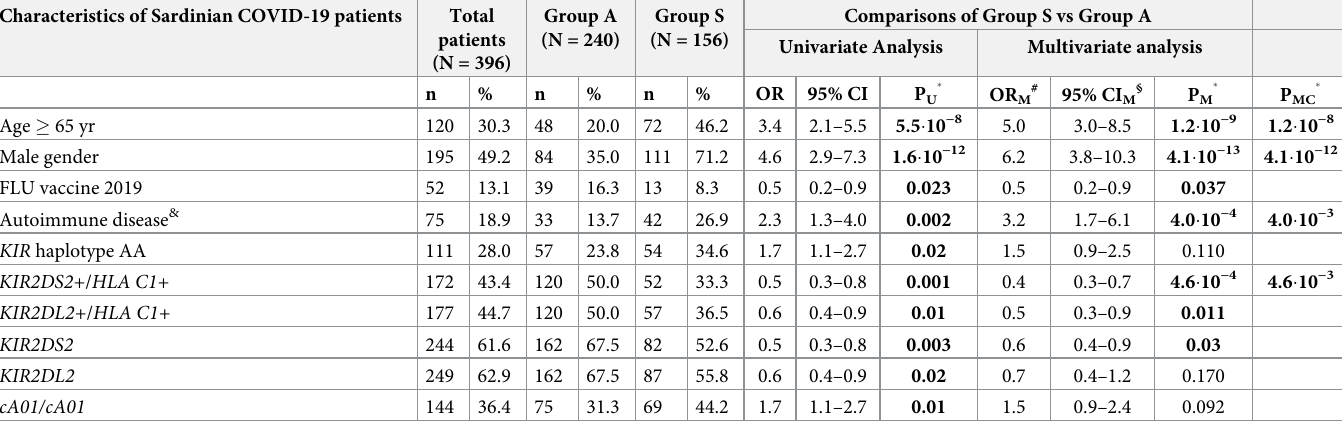
Table 6. Multivariate analysis of clinical and immunogenetic factors associated with the severity of the SARS-CoV-2 disease course. Characteristics of Sardinian COVID-19